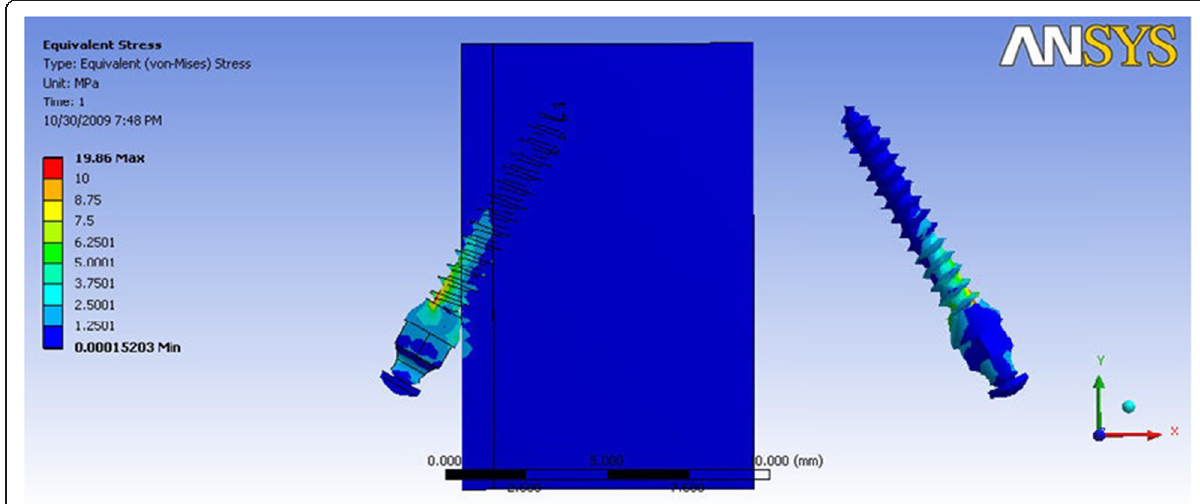
Fig. 7 von Mises stress distribution for mini-implant group 2a — molar intrusion: von Mises stress distribution seen at the bone-implant interface and in the mini-implant alone. Maximum stress seen in the mini-implant was at 19.85 MPa